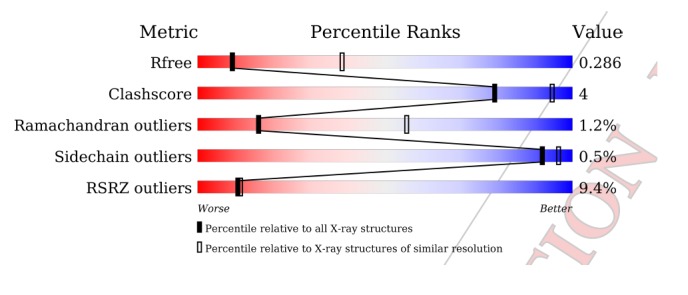
DOI:
http://dx.doi.org/10.7554/eLife.22567.022